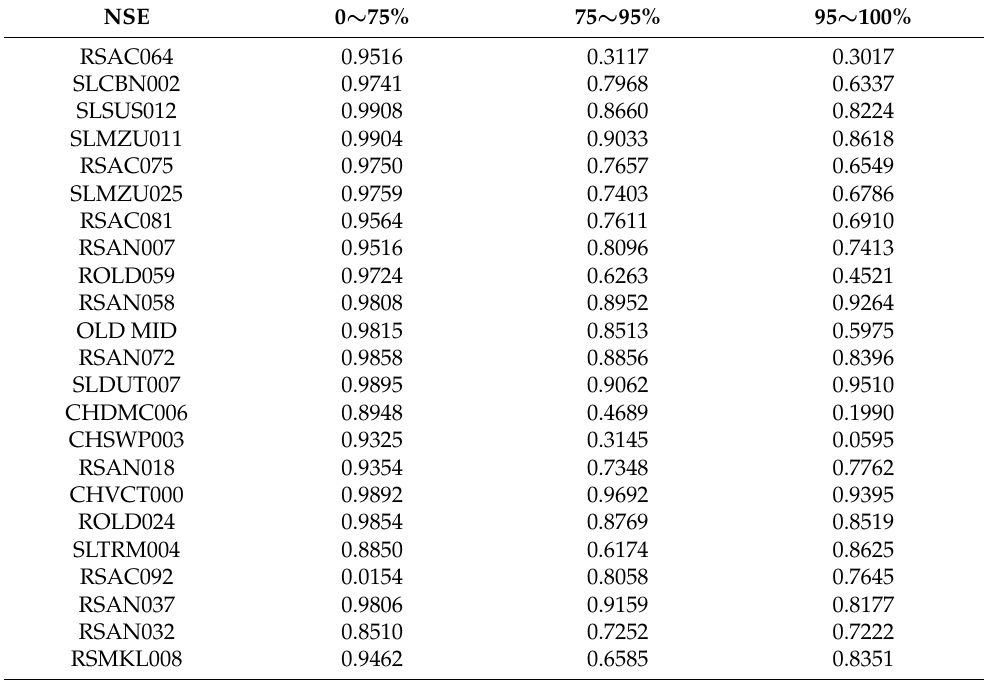
Table A5. Station-wise NSE results of Res-LSTM at hourly time step with daily inputs.